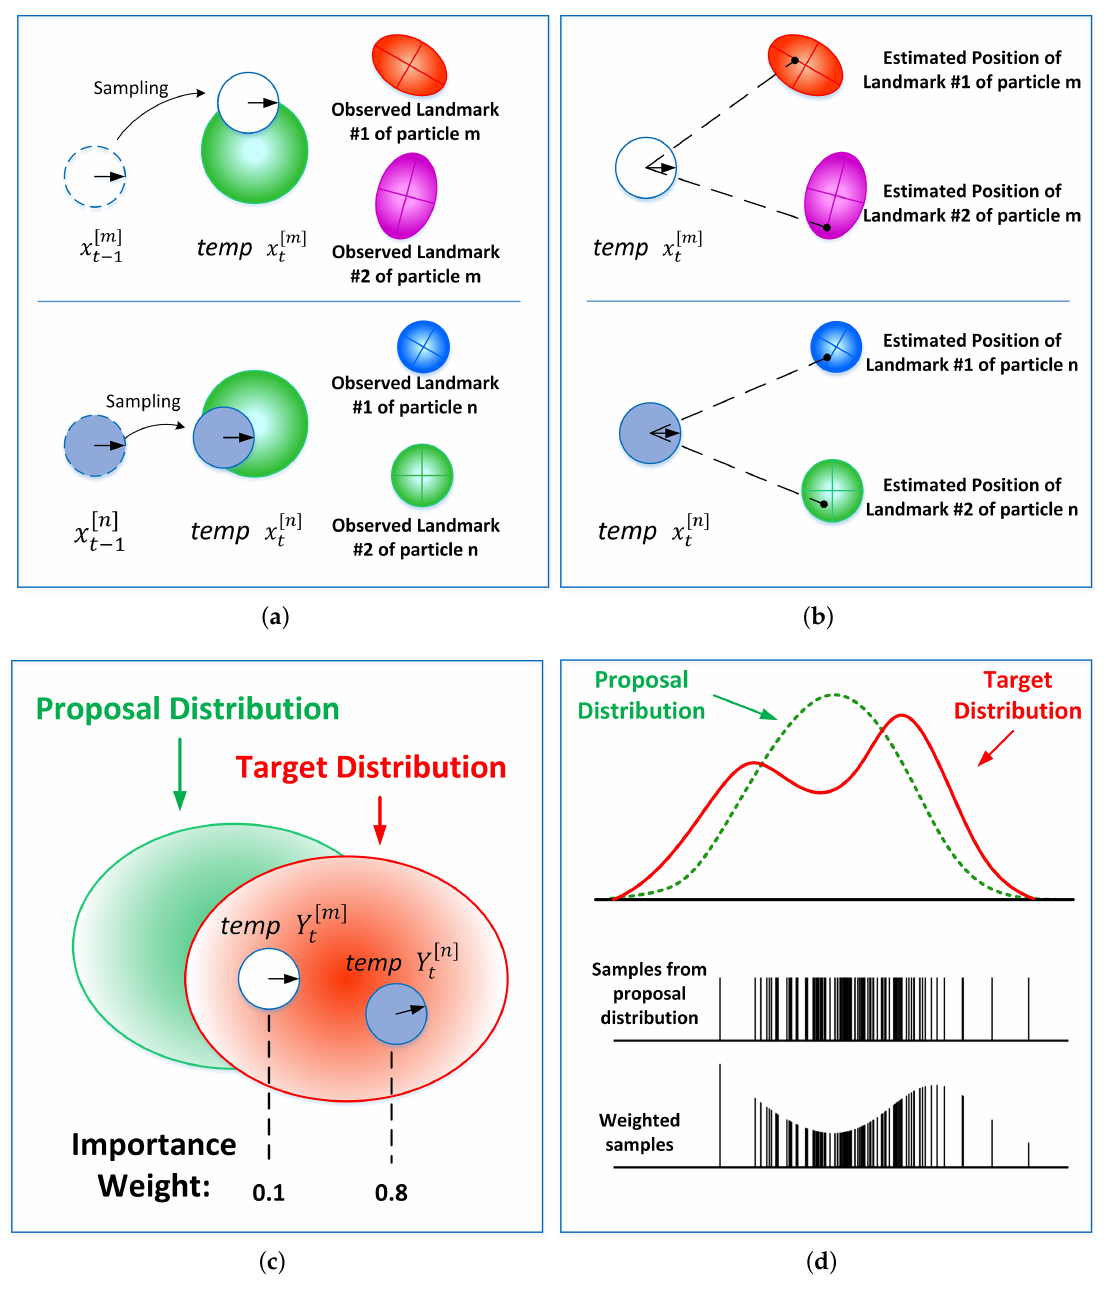
Figure 2. The process of the standard FastSLAM. ( a ) Sampling. ( b ) Measurement. ( c ) Importance weight. ( d )